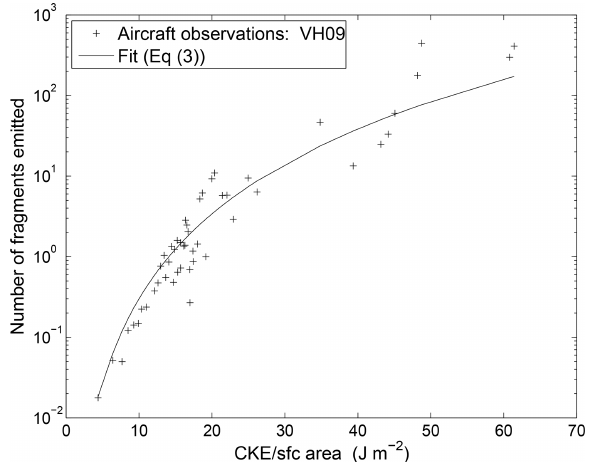
Figure 4. Measurements by Vidaurre and Hallett (2009) of numbers of fragments from ice crystals of many sizes (10–300µm), impact- ing the Formvar replicator flown at 130ms − 1 through clouds above Oklahoma, plotted as a function of the ratio of CKE to surface area of the ice particle (see Eq. 2). Source: Phillips et al. (2017a). © American Meteorological Society. Used with permission.